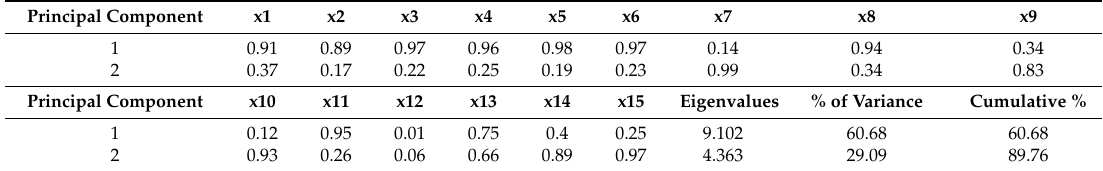
Table 6. PCA of LCTIP by SPSS 22.0.